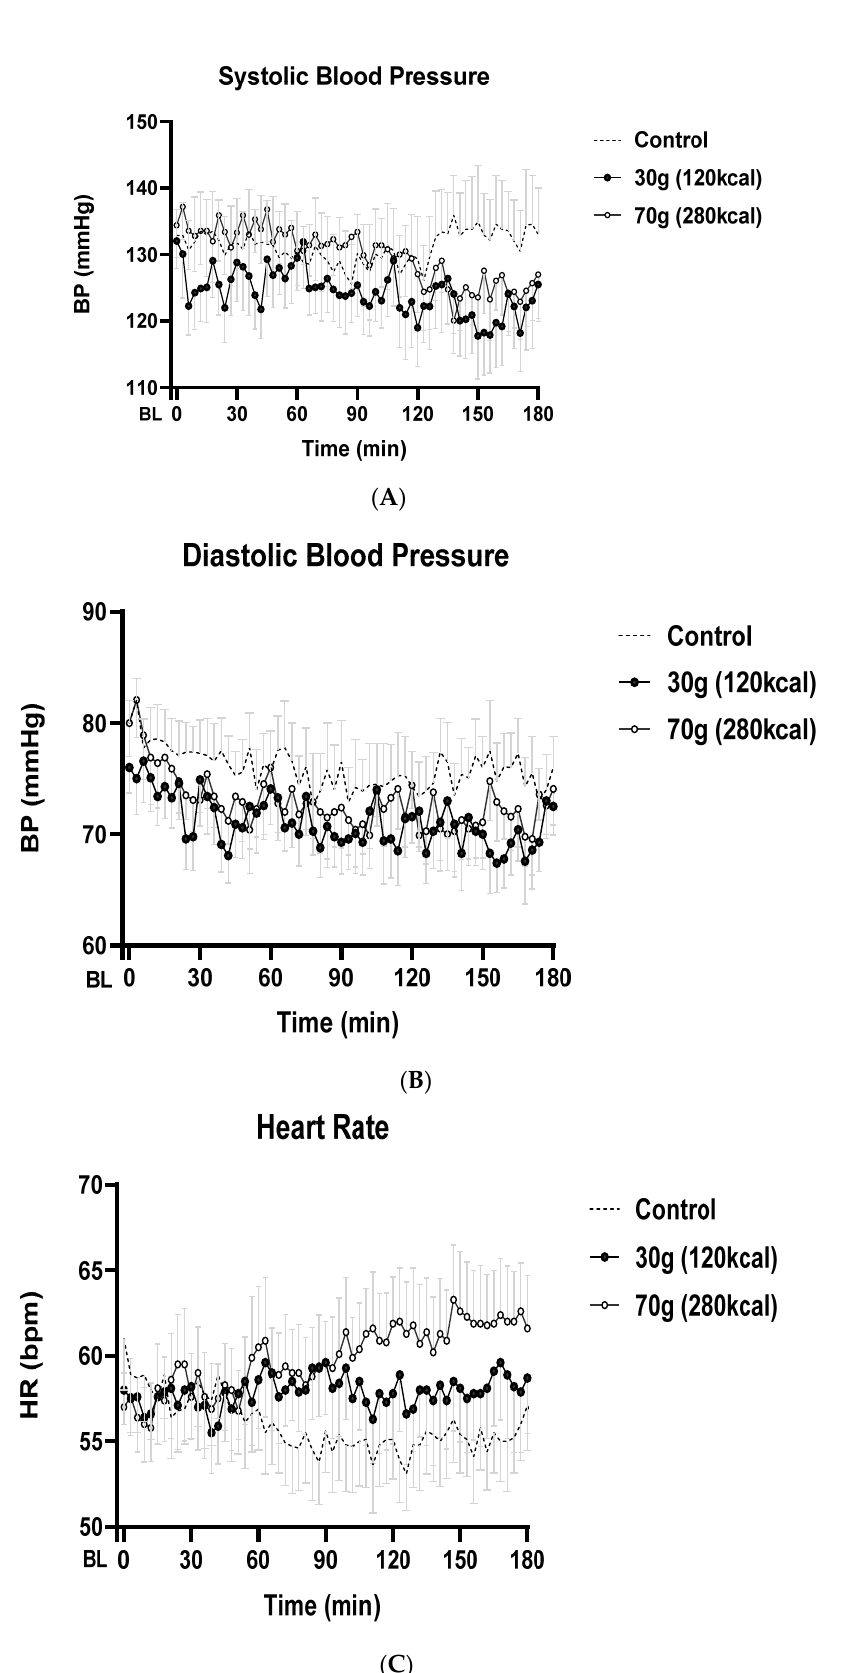
Figure 1. Mean (±SEM) systolic ( A ) and diastolic ( B ) blood pressure (mmHg) and heart rate (bpm) ( C ) following ingestion of drinks containing (i) flavored water (control, ~2 kcal) or (ii) 30 g (120 kcal) of whey protein (WP30) or (iii) 70 g (280 kcal) of whey protein (WP70) in older ( n = 8) men. The baseline blood pressure represented as ‘BL’ in the figures was calculated as an average of measure- ments at − 9, − 6, and − 3 min. T = 0 min refers to the point immediately after drink consumption. Drink condition effects were determined by using mixed model analysis. SBPs were lower after the whey protein drinks when compared to the control drink during the third hour ( p < 0.05). The mean fall in the DBP was greater after 30 g and 70 g of whey protein drinks than after the control drink. The HR was higher after the whey protein drinks when compared to the control drink during the second ( p = 0.007) and third ( p = 0.005) hours, with the greatest increase after WP70 ( p = 0.002). 3.2. Diastolic Blood Pressure (DBP) The baseline DBP was not different on the study days (C: 80 ± 2 mmHg; WP30: 76 ± 2 mmHg; WP70: 80 ± 3 mmHg; p = 0.35). The mean fall in the DBP was greater after 30 g and 70 g whey protein drinks than after the control drink, which did not achieve statistical significance during any period. Mean decreases in the DBP from baseline during the third hour were − 6/ − 8 mmHg after WP30/WP70 compared to − 4 mmHg after the control drink (mean 0–60 min, mean 60–120 min, mean 120–180 min; C: 77 ± 7, 75 ± 3, 75 ± 3 mmHg, respectively; WP30: 73 ± 2, 71 ± 3, 70 ± 3 mmHg, respectively; WP70: 75 ± 3, 72 ± 3, 72 ± 3 mmHg, respectively; p = 0.23, p = 0.41, p = 0.20, respectively; Figure 1B, Table 1). Maximal changes in the DBP from baseline (C: − 13 ± 2 mmHg; WP30: − 15 ± 1 mmHg; WP70: − 17 ± 2 mmHg; p = 0.13) occurred ~1.5–2 h after drink ingestion, with the nadir occurring latest after the 70 g whey protein drink (C: 89 ± 19 min; WP30: 98 ± 19 min; WP70: 108 ± 11 min; p = 0.74). 3.3. Heart Rate (HR) The baseline HR was not different between the study days (C: 61 ± 3 bpm; WP30: 58 ± 2 bpm; WP70: 57 ± 2 bpm; p = 0.56). The HR was higher after the whey protein drinks when compared to the control drink during the last 2 hours (mean 0–60 min, mean 60–120 min, mean 120–180 min; C: 55 ± 3, 55 ± 2, 55 ± 2 bpm, respectively; WP30: 58 ± 3, 60 ± 3, 58 ± 3 bpm, respectively; WP70: 59 ± 3, 60 ± 3, 62 ± 3 bpm, respectively; p = 0.05, p = 0.007, p = 0.005, respectively), with the greatest increase after WP70 and during the third hour (change from baseline to 120–180 min: C: − 5 ± 1 bpm; WP30: 0 ± 1 bpm; WP70: +5 ± 1 bpm; p < 0.05; Figure 1C, Table 1). The maximal increase in the HR from baseline (C: 2 ± 1 bpm;